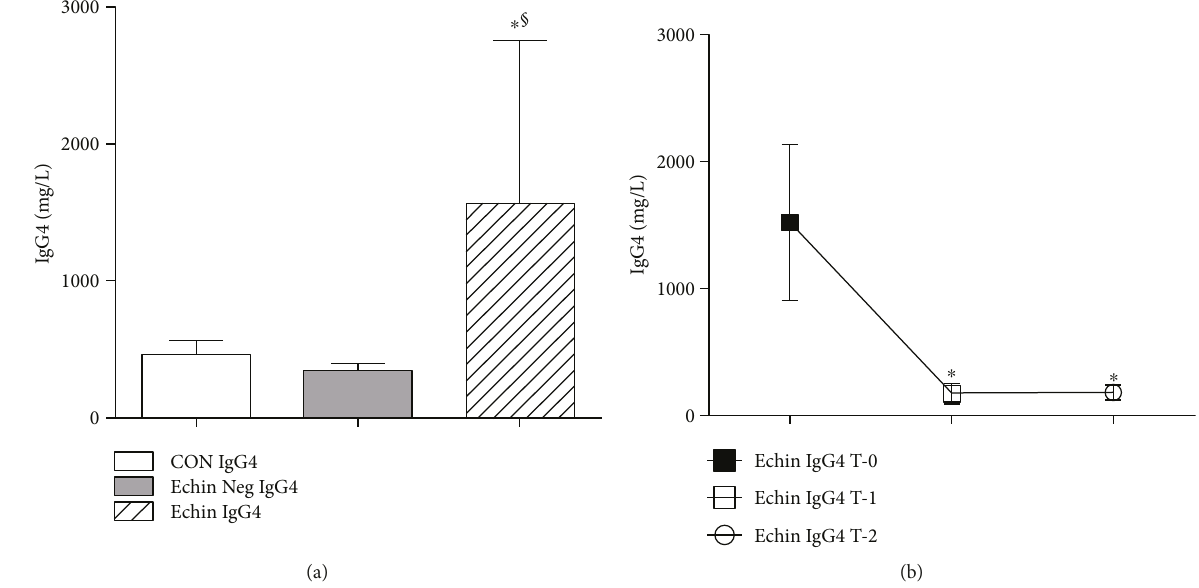
Figure 7: (a) Serum levels of IgG4 in the group of infected patients (Echin IgG4) are signi fi cantly increased ( p < 0 05 ) versus the same parameters in the group of Echin-negative patients (Echin Neg IgG4) and in the group of control subjects (CON IgG4). Values are expressed as mean ± SEM. ∗ p < 0 05 versus CON; § p < 0 05 versus Echin Neg, after ANOVA and Fisher PLSD test. (b) IgG4 levels showed a signi fi cant decrease in parasite-infected patients one week after surgery (time T-1) ( p < 0 05 ) compared with the levels found in patients before any therapy (time T-0); such reduction was observed even 1-2 months after therapy (time T-2). ∗ p < 0 05 versus Echin IgG4 T-0, after ANOVA and Fisher PLSD